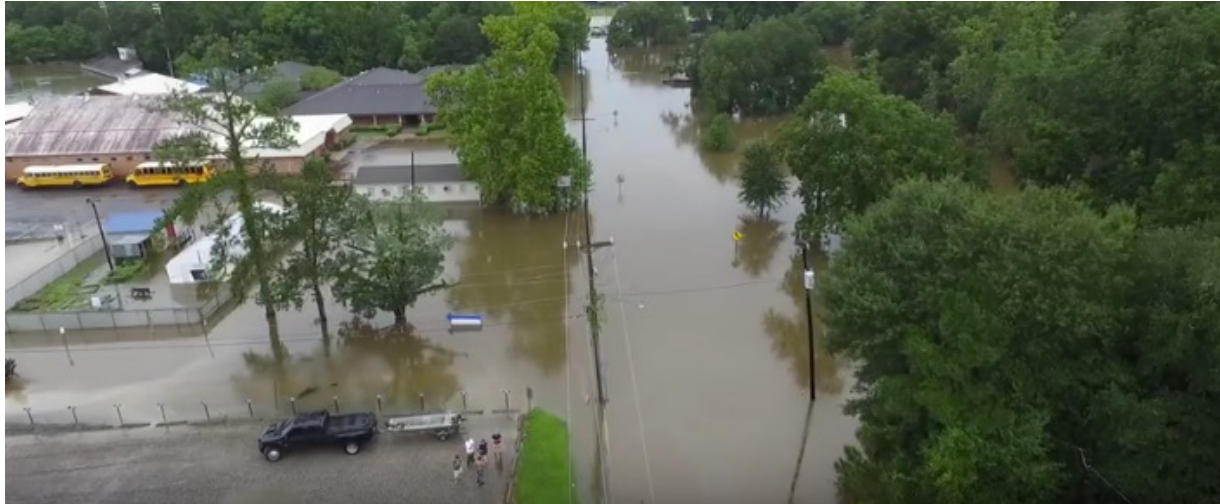
Figure 4: Downtown Springfield and parts of Highway 22 towards Ponchatoula captured by Dev/Null, “Louisiana Flood 2016—Springfield Hwy 22—Drone Aerial Footage.” Source: YouTube, Aug 15, 2016.